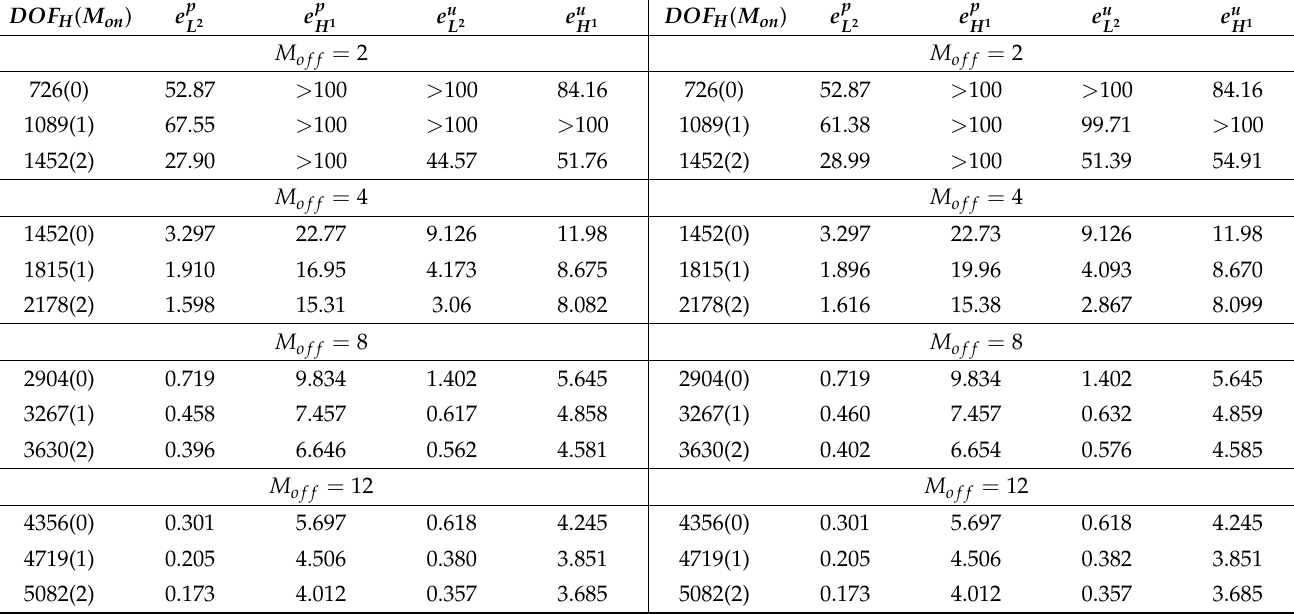
Table 2. Case 2 . Relative errors for displacement and pressures with a different number of offline and online basis functions ( M of f and M on ). Online basis functions are updated every 5 and 10 time steps (left and right,